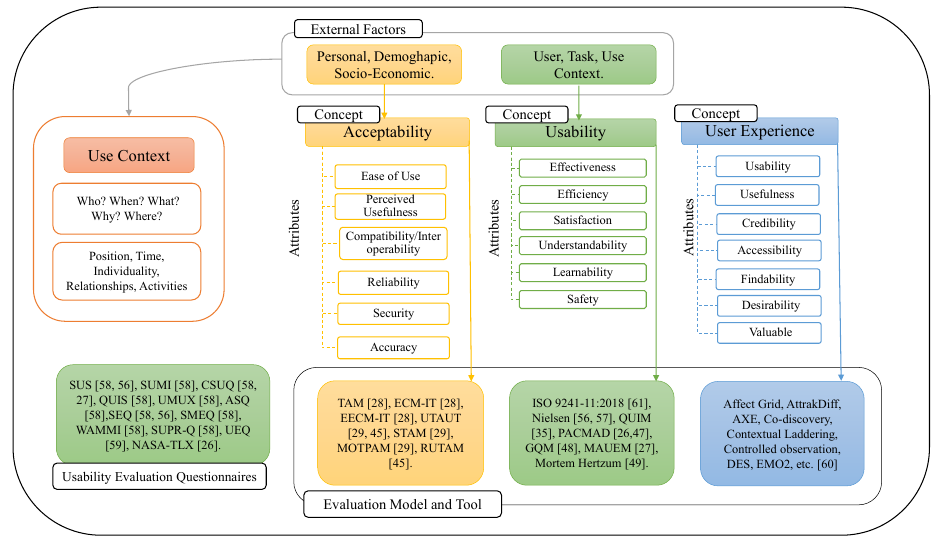
Figure 4. Selected Categories and classification for each level of the evaluation model. The synthesis and the procedure of the literature survey conducted and detailed in the supplementary information document, in order to select, classify and assess several attributes and sub-attributes for each level of the proposed evaluation